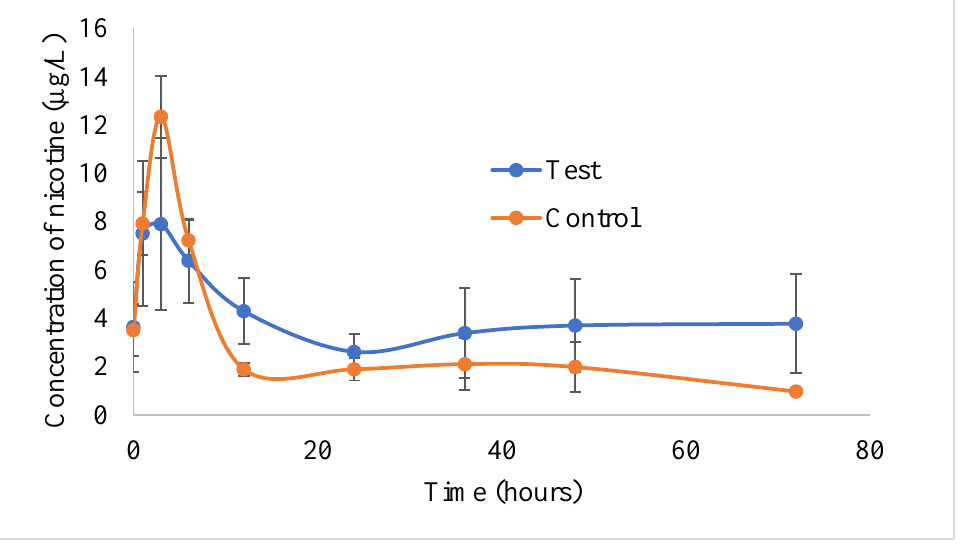
Figure 6. Plasma concentrations of nicotine in rabbits following transdermal application of the control and test gel formulations. Values are represented as mean ± S.E.M, n = 4.